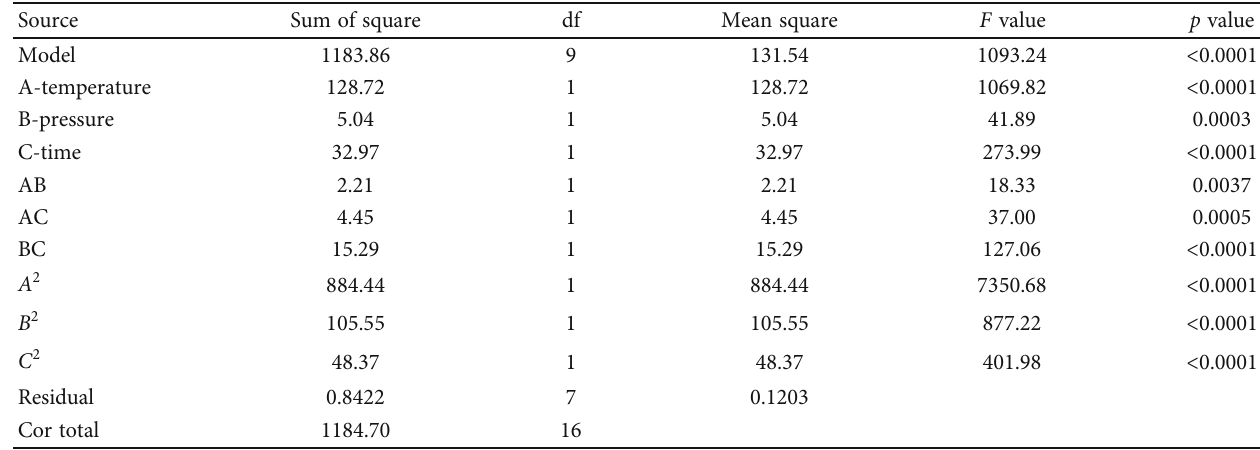
Figure 7: Impact behavior of (a) pressure vs. time; (b) temperature vs. pressure; (c) temperature vs. time of CGF- and hemp-based hybrid composites. Table 2: ANOVA for tensile